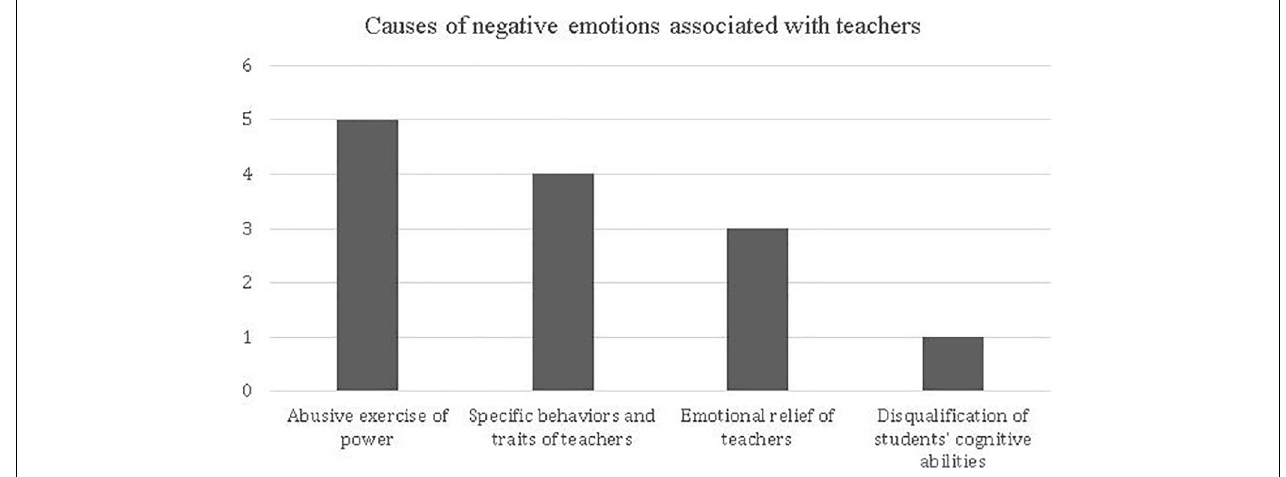
FIGURE 8 | Frequency of the different dimensions of the teacher as a facilitator of negative emotions, according to the memories of the future teachers analyzed.